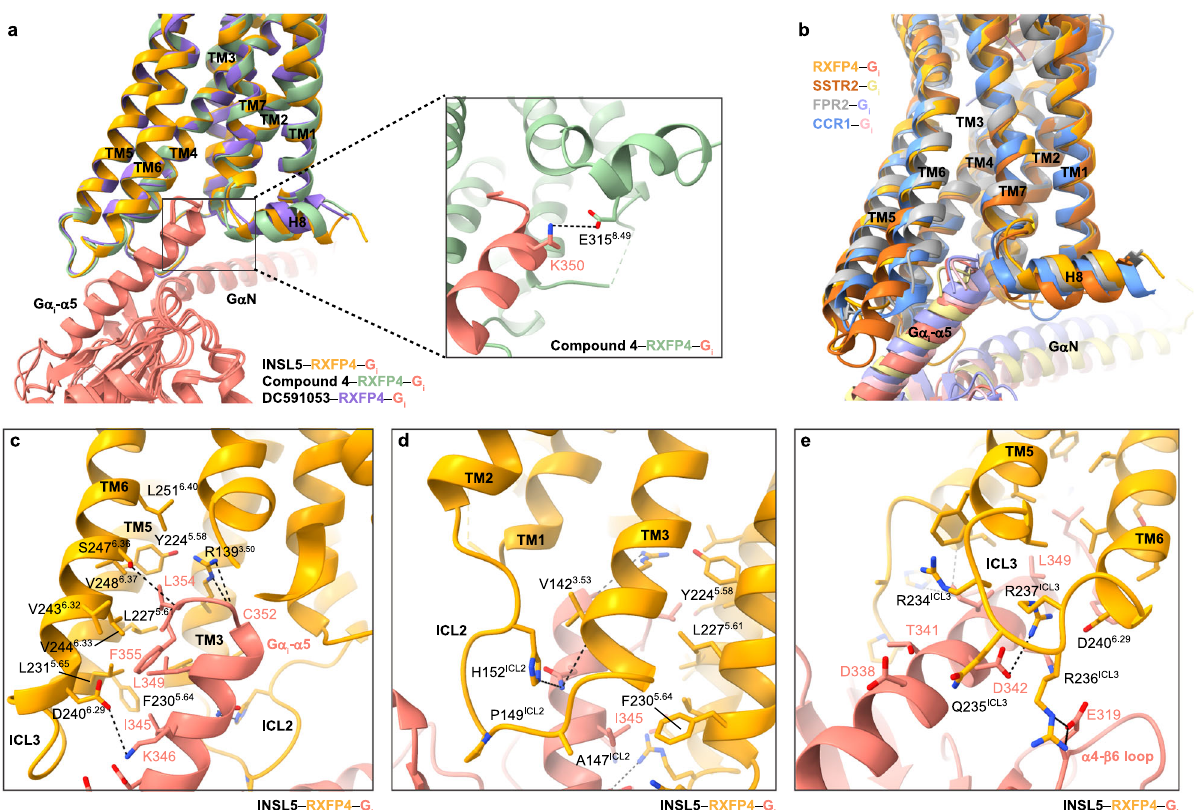
Fig. 4 | G protein coupling of RXFP4. a G i -coupling is almost identical among INSL5-, compound 4- and DC591053-bound RXFP4 structures. The alignment is basedonthe receptor.One salt bridgebetween helix8 (H8)and α 5 helix ofG i was only found in the compound 4-bound RXFP4-G i complex. b Comparison of G proteincoupling among INSL5-bound RXFP4,FPR2(PDB code: 7WVV),CCR1 (PDB